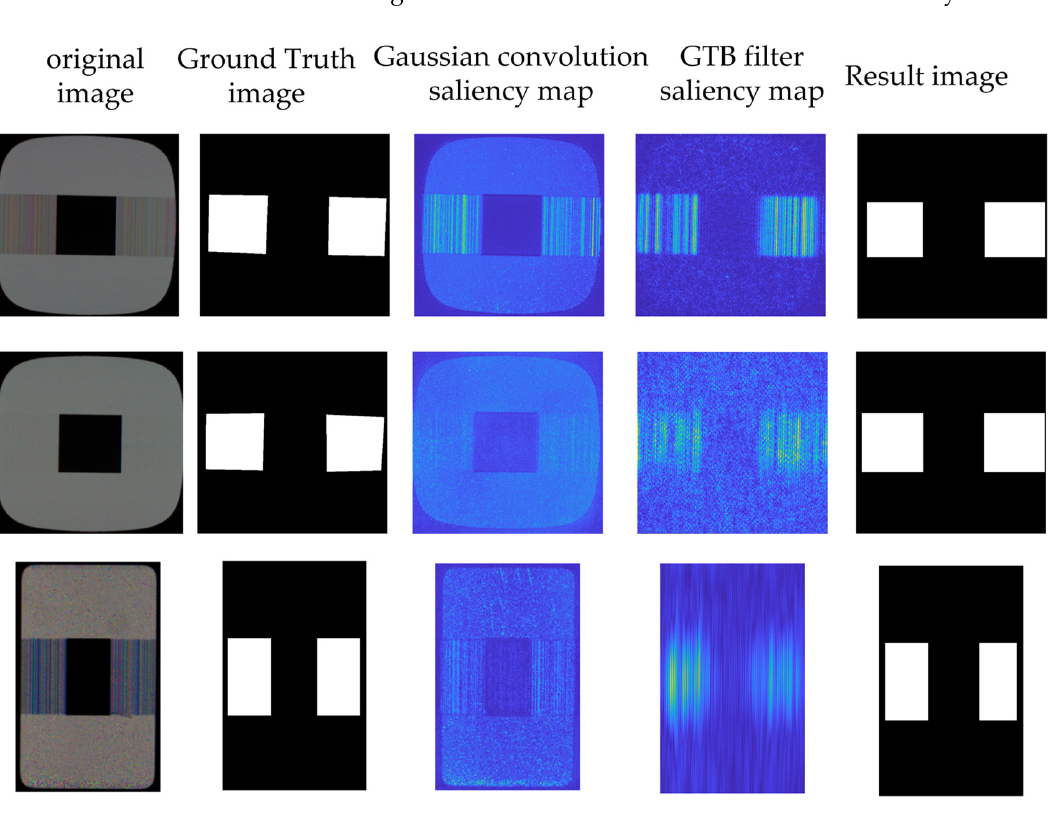
Sensors 2022 , 22 , x FOR PEER REVIEW Figure 5. Comparison of GTB methods. Figure 5. Comparison of GTB methods.